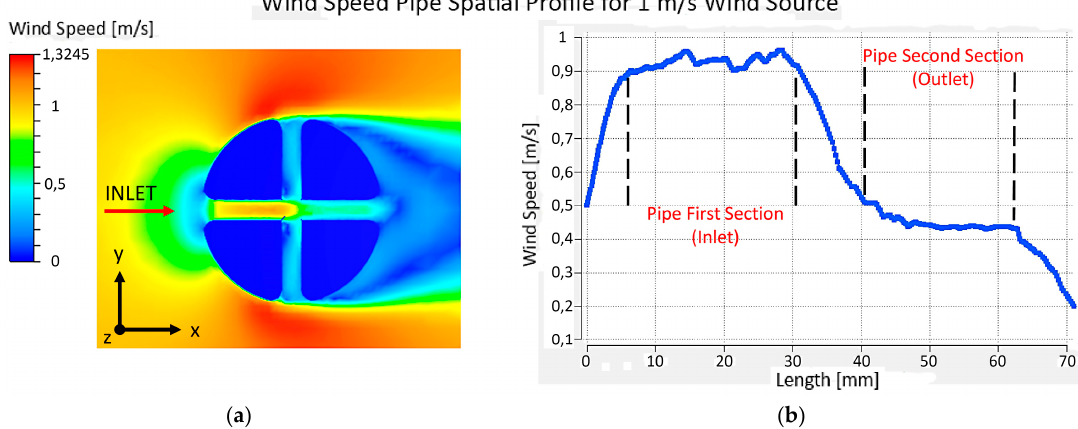
Figure 2. ( a ) XY cut-plane wind speed profile for the proposed spherical structure; ( b ) spatial wind speed distribution along the symmetry axis of the x-pipe